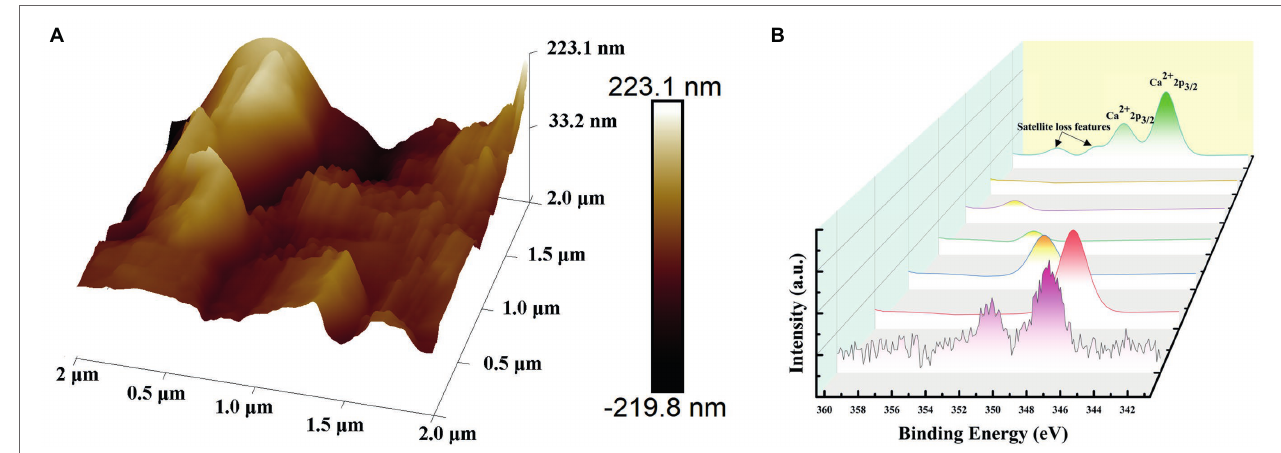
FIGURE 6 | Images of the PVC hollow fiber membrane surfaces showing Ca levels after operation during the stable phase. Showed in (A) Atomic force microscopy (AFM) and (B) X-ray photoelectron spectroscopy